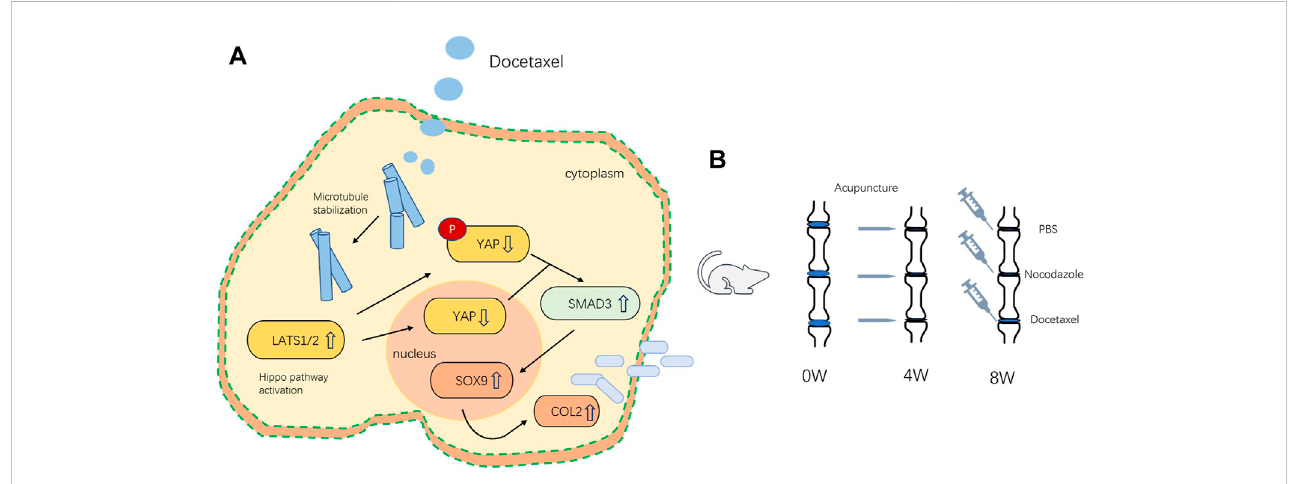
FIGURE 8 (A) Schematic of the mechanism by which microtubule stabilization promotes the synthesis of COL2 in NP Cell. (B) Schematic illustration of rat intervertebral disc modeling and